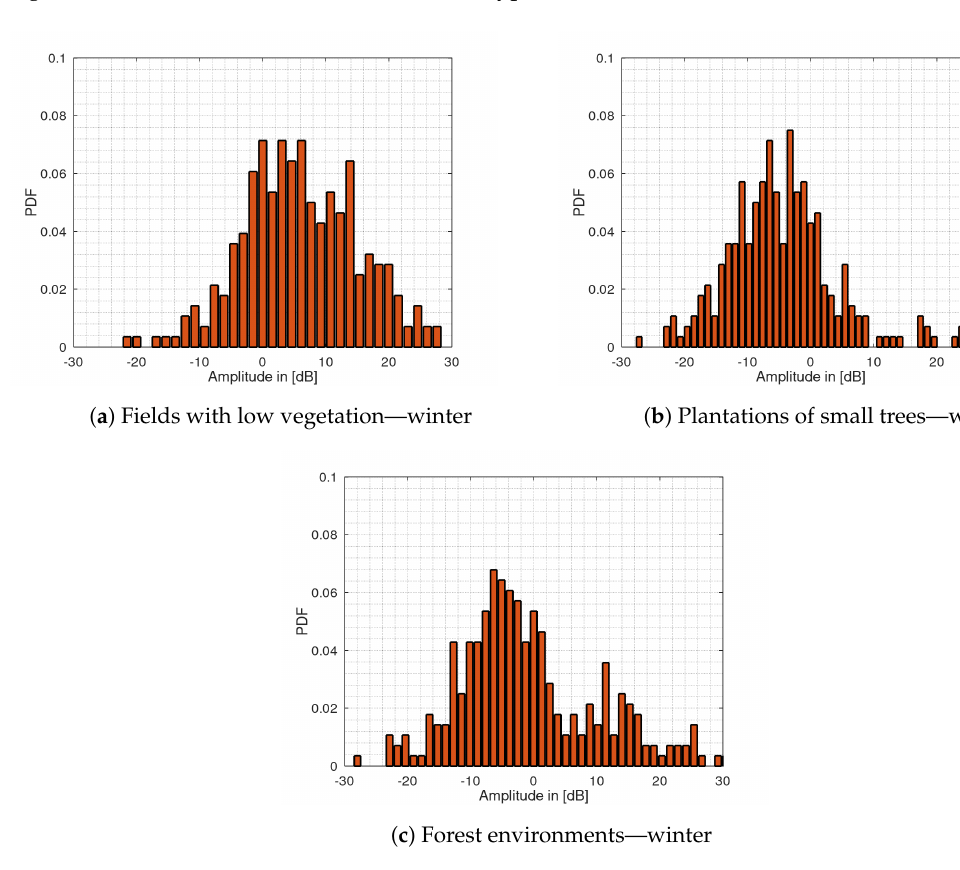
Figure 6. Histogram plots of the clutter amplitudes during winter measurements for ( a ) fields with low vegetation, ( b ) plantations of small trees and ( c ) forest environments. Table 1. Pearson correlation coefficients for the different clutter histograms of the fields with low vegetation, plantations of small trees and forest environments and the corresponding winter